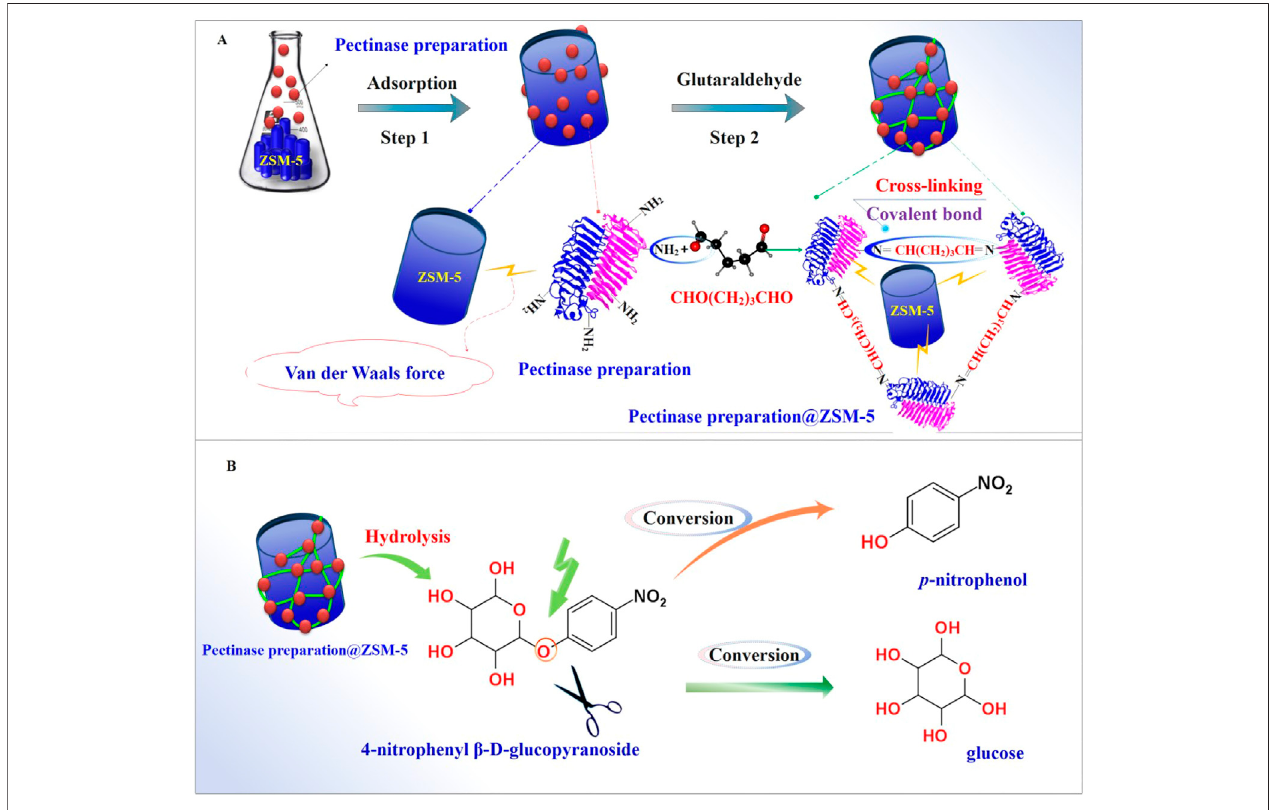
FIGURE 1 | Fabrication and application of the pectinase preparation@ZSM-5 catalysts. Schematic diagrams of (A) pectinase preparation@ZSM-5 fabrication and (B) catalytic hydrolysis of the model substrate 4-nitrophenyl β -D-glucopyranoside (PNPG) using pectinase preparation@ZSM-5.